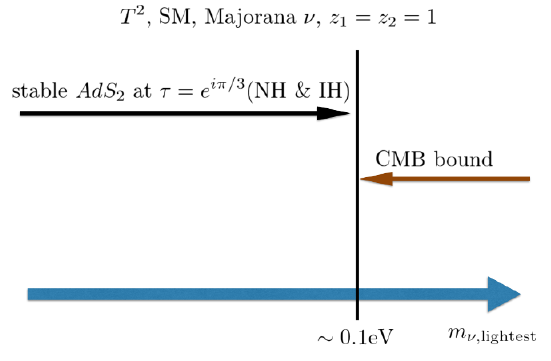
Figure 15 . Left: the value of (cid:26) (cid:3) which satis(cid:12)es V ( (cid:26) (cid:3) ) = 0. Right: the ratio between the mass of the (cid:28) moduli and the curvature of the 2-dimensional spacetime. One can see that the only perturbatively stable vacuum is the AdS minimum with (cid:28) = e i(cid:25)= 3 .